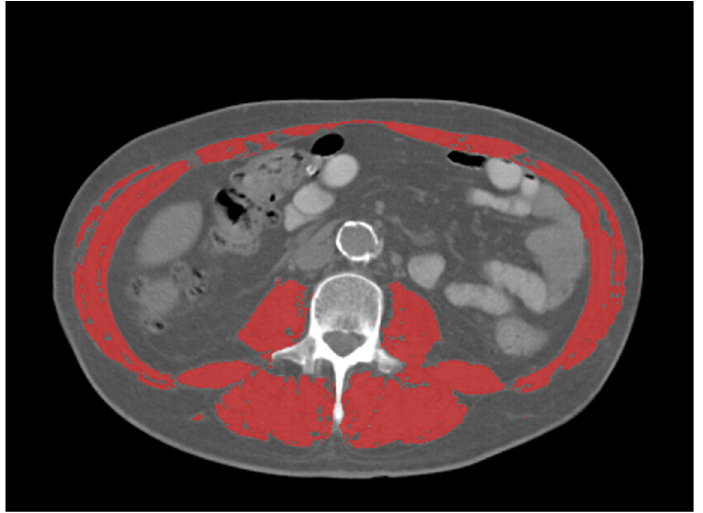
Figure 1. Representative example of skeletal muscle measurements on CT at the level of L3 (outlined in red). Thresholds for skeletal muscle were − 29–150 HU.